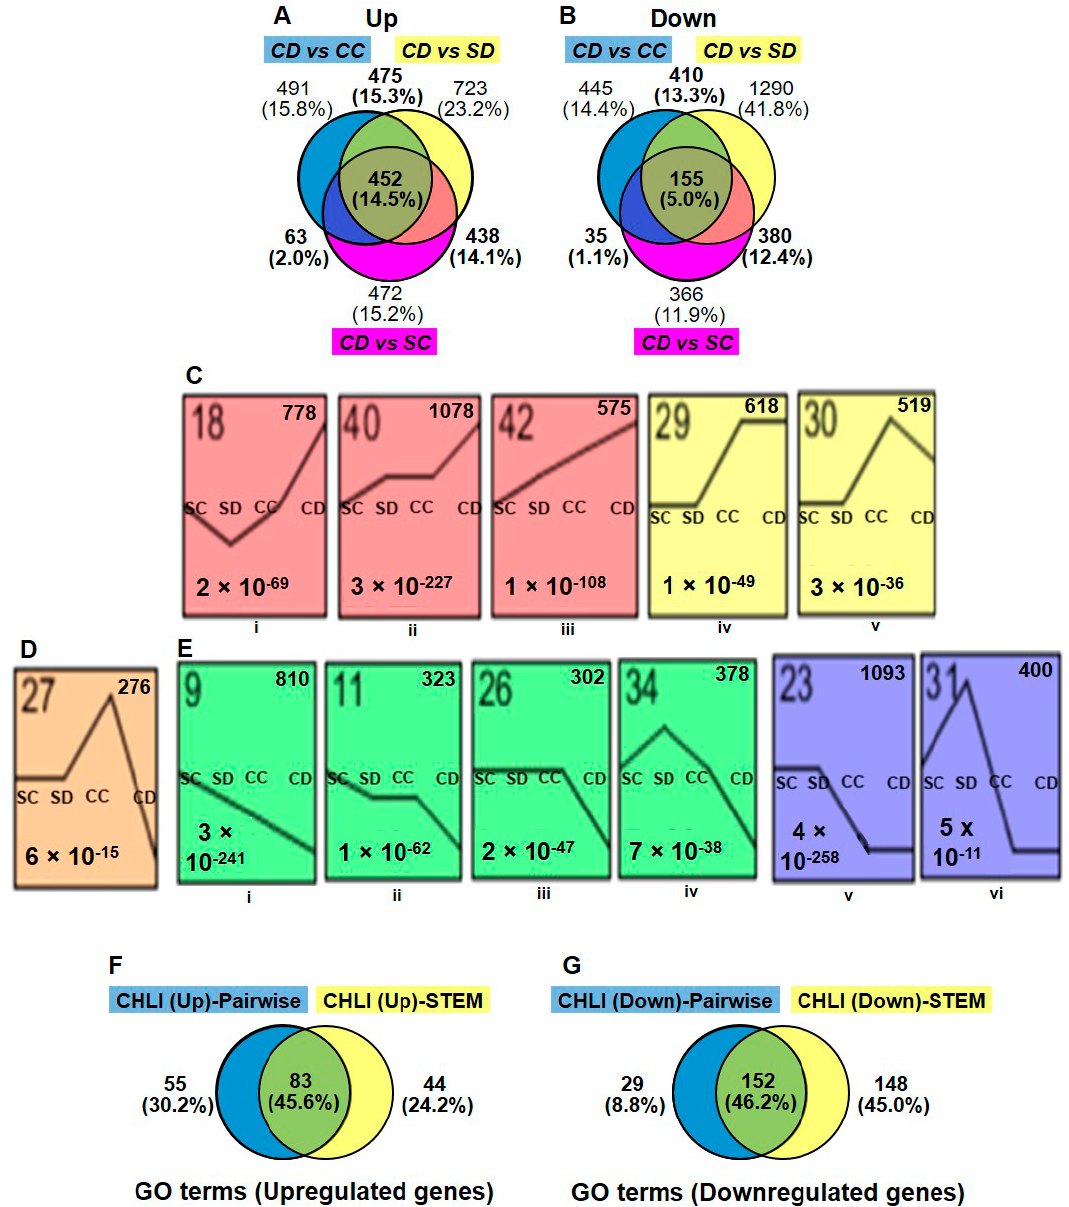
Figure 2. Selection of differentially expressed genes. Differential expression analyses were made using DESeq2 as mentioned in materials and methods in three different comparisons: Dex-treated C-1 vs. control C-1 (CD vs. CC), Dex-treated C-1 vs. Dex-treated SR1 (CD vs. SD), and Dex-treated C-1 vs. Control SR1 (CD vs. SC). The numbers and relationships within comparisons of up- ( A ) and down-regulated ( B ) differentially expressed genes (DEGs) are shown in Venn diagrams. ( C , D , E ) The gene expression patterns among the four different groups (SC, SD, CC, and CD) inferred by STEM analysis ( p -value < 0.05). Each box corresponds to a different model expression profile. The black lines represent the expression tendency of the genes classified therein. The profile number is shown in the upper-left, the number of genes belonging to each pattern in the upper-right, and the p -value for each profile in the lower-left of the frame. Sets of expression profiles were selected to represent up-regulated ( C ), down-regulated ( D ) DEGs and, ( E ) show the DEGs which are up-regulated in CC but down-regulated in CD plants. ( F , G ) Comparison of the gene ontology (GO) enrichment results of pairwise (DESeq2) and STEM analysis. Venn diagrams show numbers and relationships between analyses of GO terms (biological process) enriched by up-regulated DEGs ( F ) and downregulated DEGs ( G